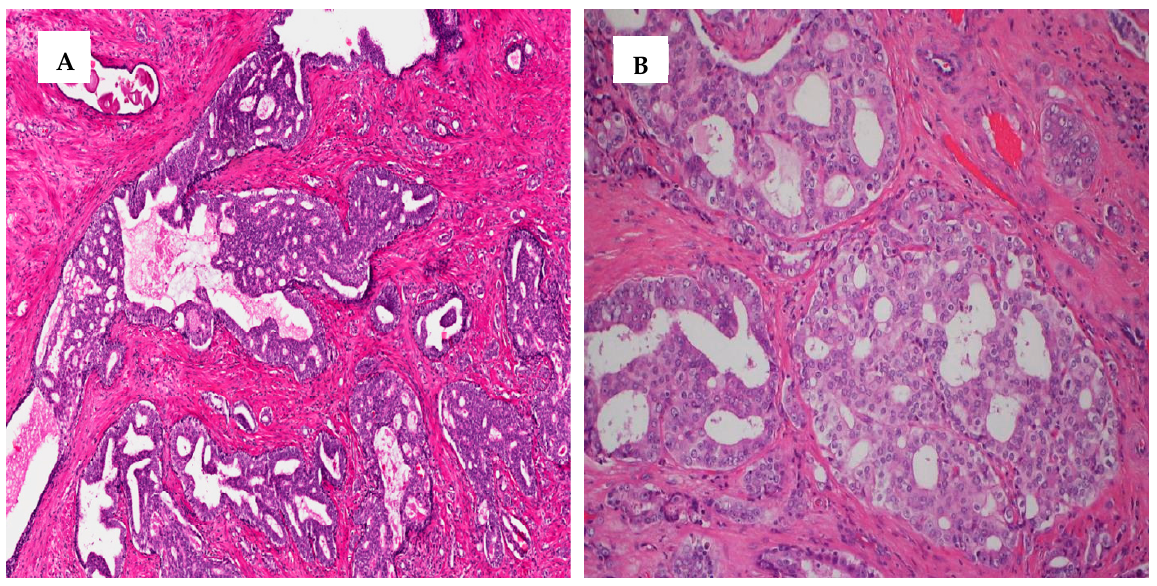
× ) ( A ) and invasive cribriform PCa (20 × ) ( B